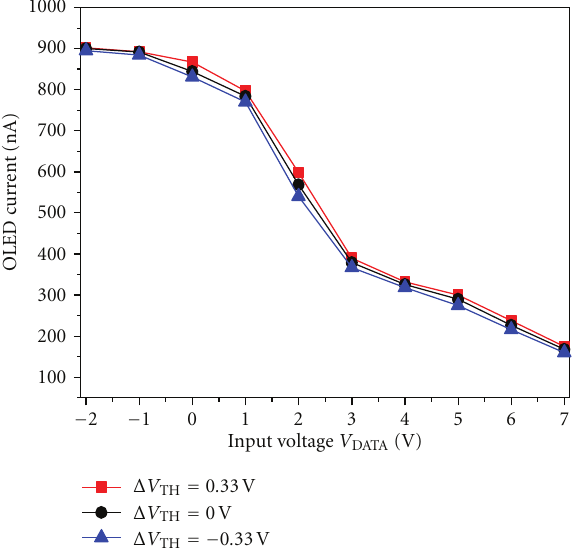
Figure 7: OLED current as a function of V DATA owing to the variation with the threshold voltage of DTFT for 3T1C AC driving pixel circuit.